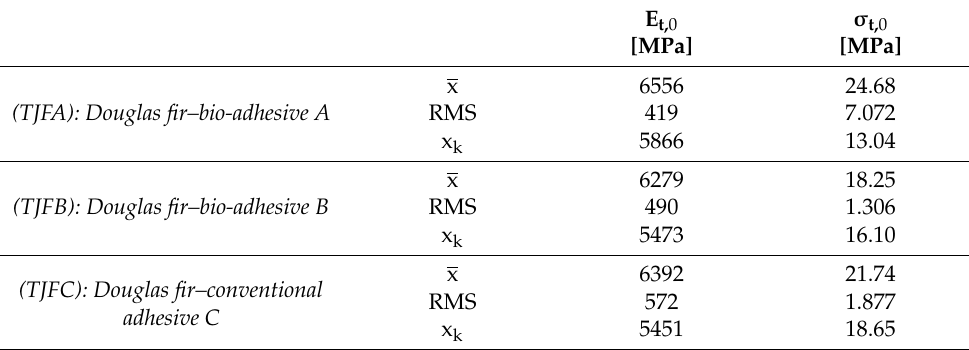
Table 4. Results for Douglas fir scarf-joint tensile properties.